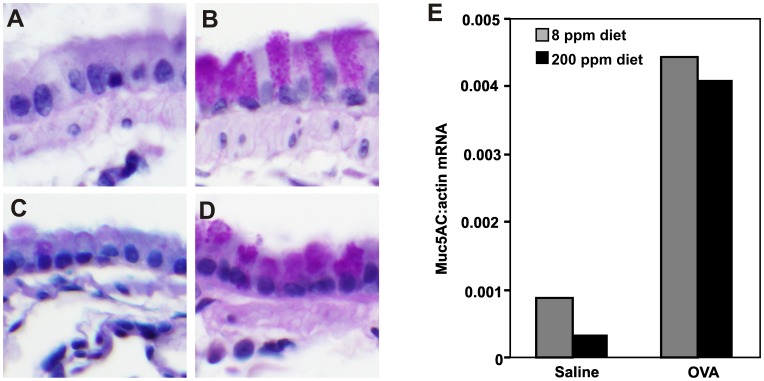
Iron supplementation does not affect mucus production.Periodic acid-Schiff (PAS)-stained formalin-fixed, paraffin-embedded lung sections show allergen-induced goblet cell differentiation in the large airways of mice on both 8 ppm (A  =  saline-challenged, B  =  OVA-challenged) and 200 ppm diets (C  =  saline-challenged, D  =  OVA-challenged). Expression of Muc5AC mRNA in the lungs was similar for both diet groups (E).